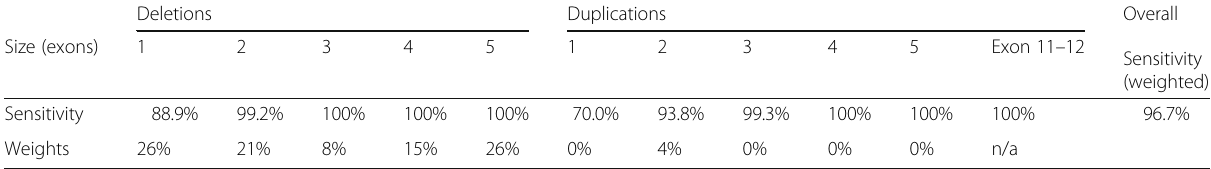
Table 2 CNV simulations demonstrate high analytical sensitivity